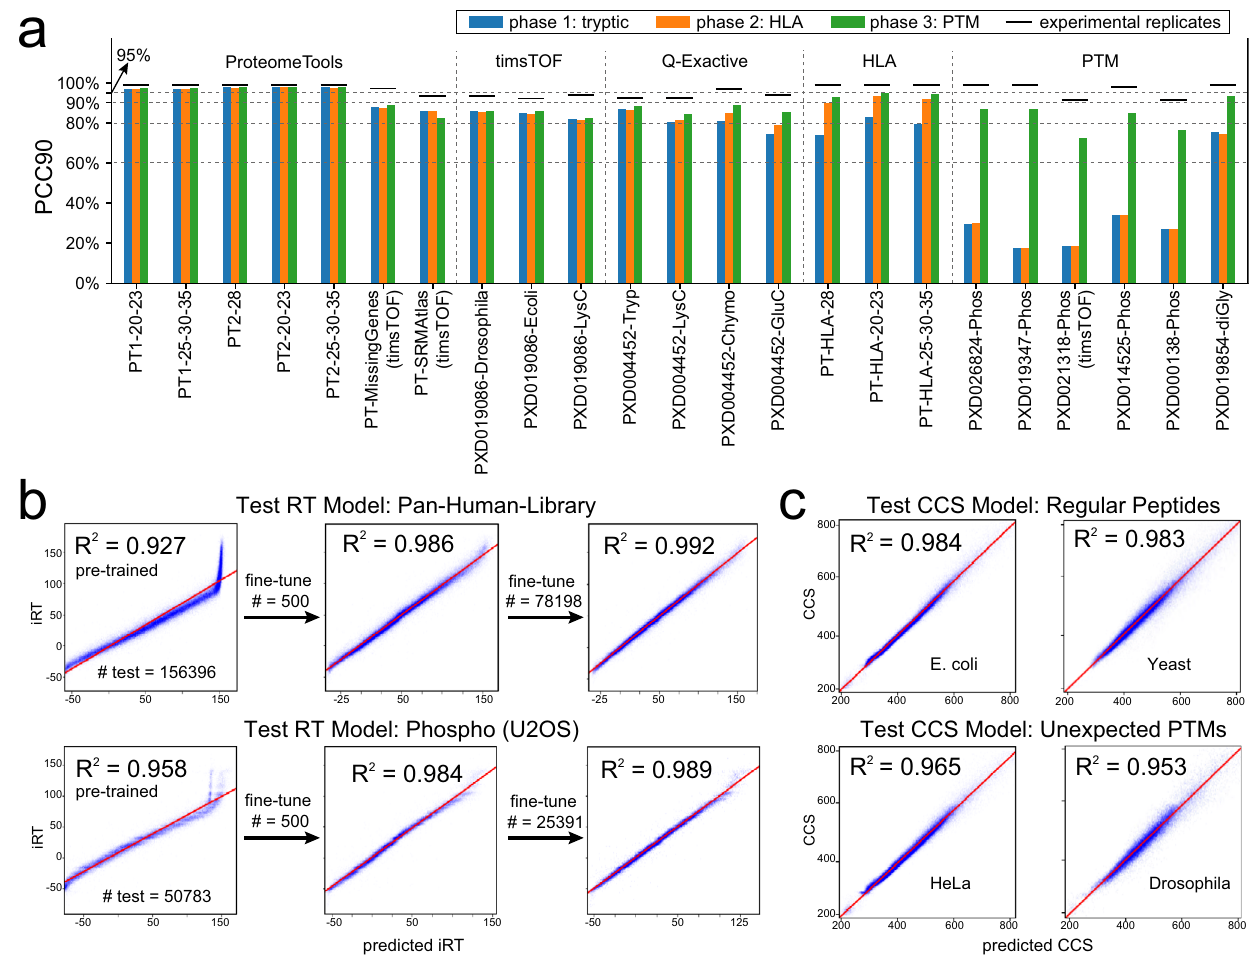
Fig. 3 | The performance of MS2/RT/CCS models. a The MS2 prediction accura- cies of the three training phases on different testing datasets. The dataset names are on the x-axis. The performance is evaluated by “ PCC90 ” (percentage of PCC valueslargerthan0.9).Thepre fi x ‘ PT ’ ofeachdatasetreferstoProteomeTools.PT1 and PT2 refer to ProteomeTools part I and II, respectively. PT1, PT2, and PT-HLA were all measured with Lumos by the Kuster lab. The black bars are the PCC90 values of experimental spectra. b For RT prediction, few-shot learning can correct